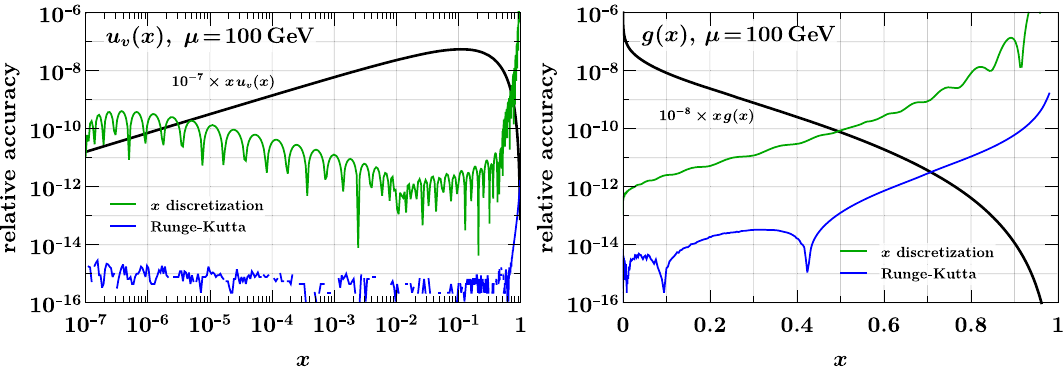
Fig. 13 Relative accuracy of NNLO DGLAP evolution and flavor matching, distinguishing the contributions due to x -space discretization (green) and the Runge–Kutta algorithm (blue). The plot on the left shows xu v ( x ) and the plot on the right x g ( x ) . Notice the different scales in